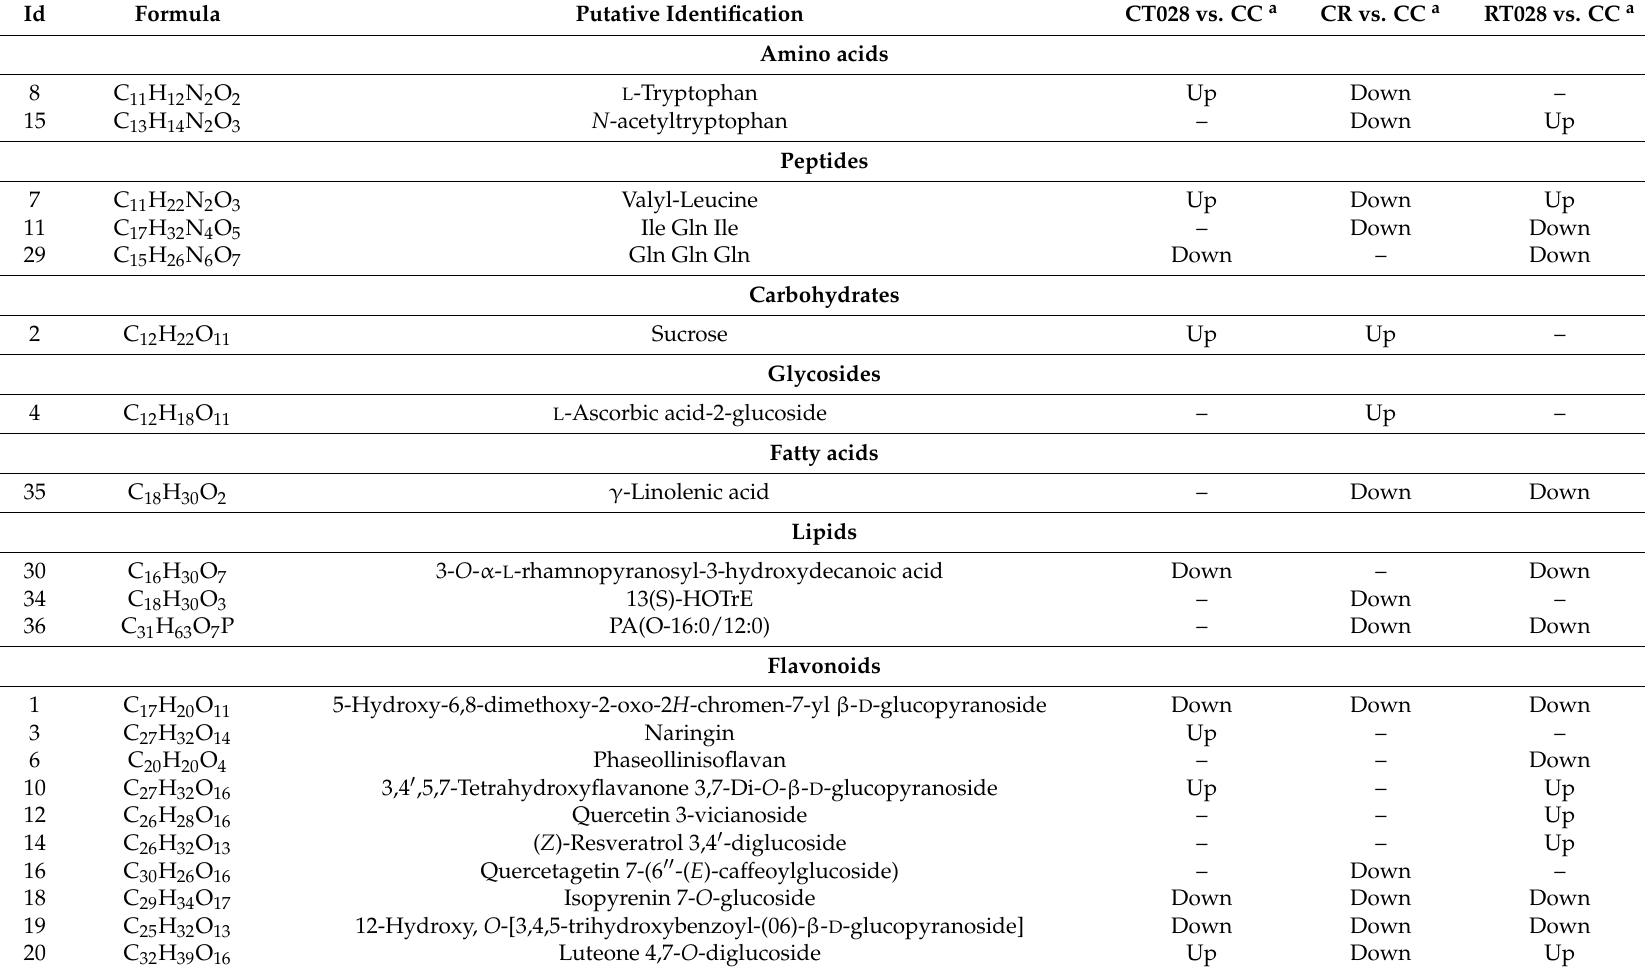
Table 2. Homologies of putatively identified compounds in the bean metabolome and changes in their accumulation pattern occurring when different interaction conditions (three-way, two-way and no interaction) were